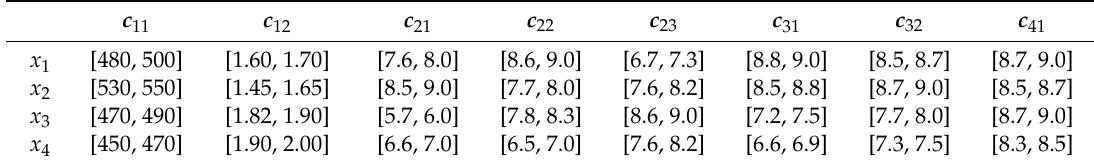
Table 5. Assessments of the four tourism scenic spots with respect to each of the sub-criteria at the lowest level.